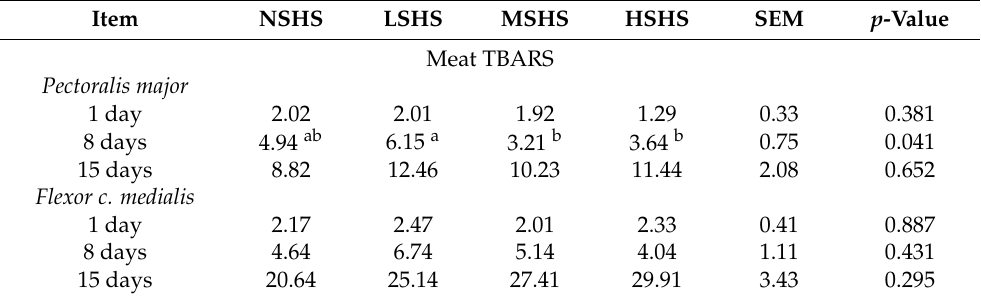
Table 6. Effects of level of electrical stunning, halal neck cutting, and subsequent bleeding on